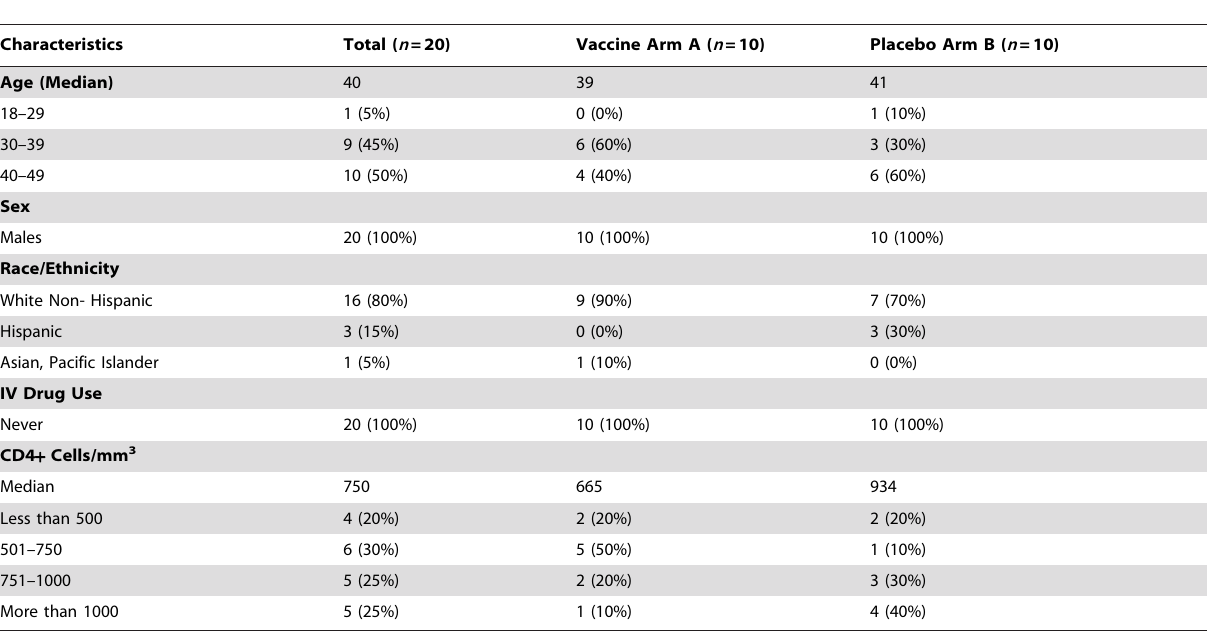
Table 1. Baseline Characteristics by Treatment